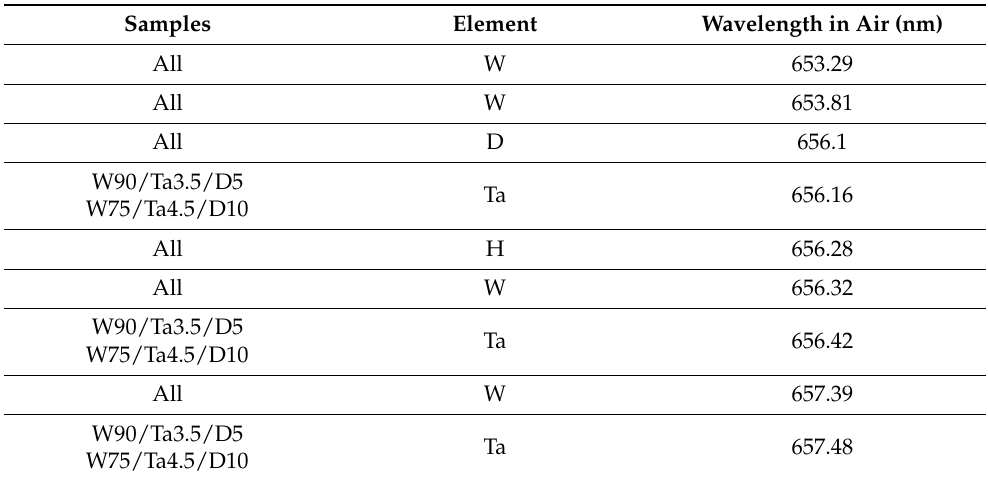
Table 1. Relevant emission lines of W-Ta-D in the 653–660 spectral region according to